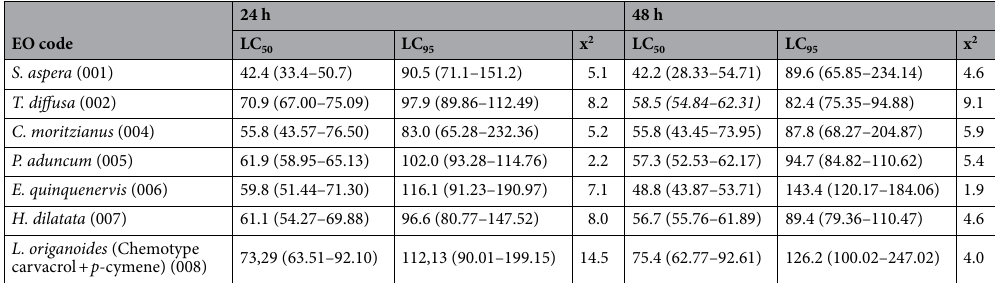
Table 1. Essential oil lethal concentrations on A. aegypti larvae. Values are expressed in µg/mL at 24 h and 48 h. Lethal concentration 50 (LC 50 ), Lethal concentration 90 (LC 90 ). x 2 , indicates dependence between LC 50 and LC 90